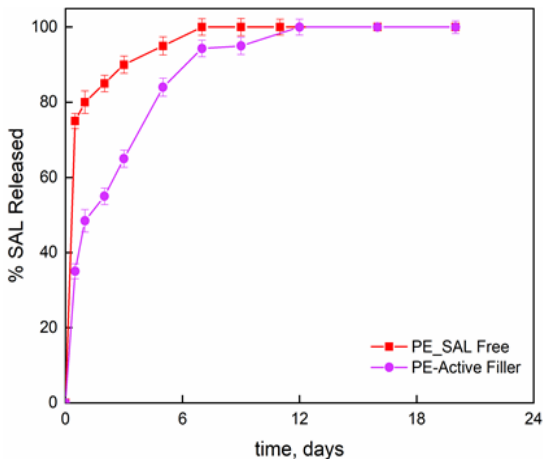
Figure 2. Release of salicylate anchored to LDH in PE-Active Filler and salicylate at 8 wt% free dispersed into PE film.